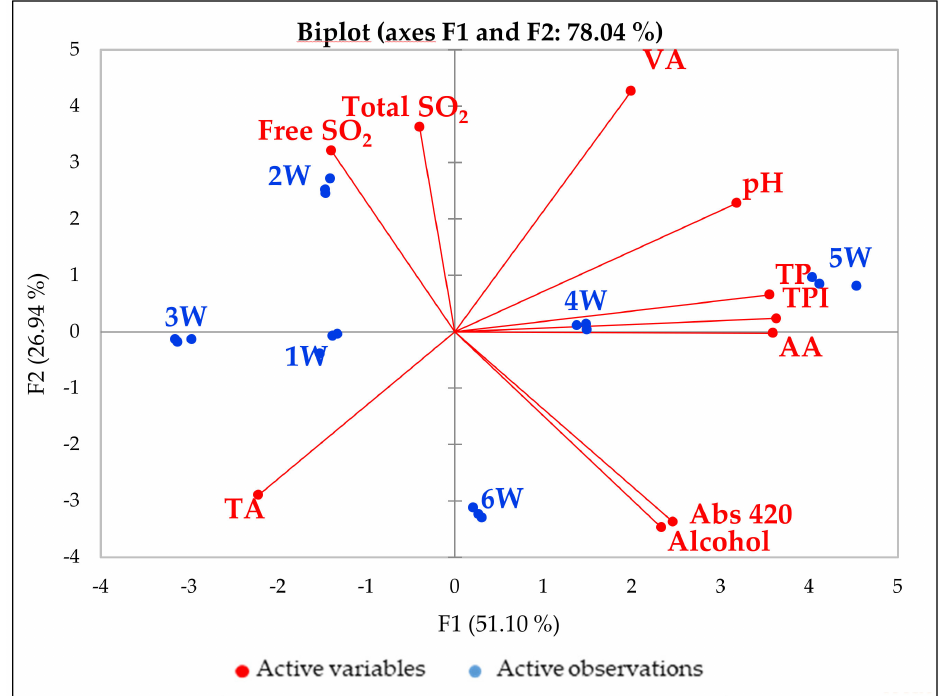
Figure 2. PCA of the 6 white wines. Total acidity (TA); volatile acidity (VA); total phenol (TP); total phenol index (TPI280); antioxidant activity